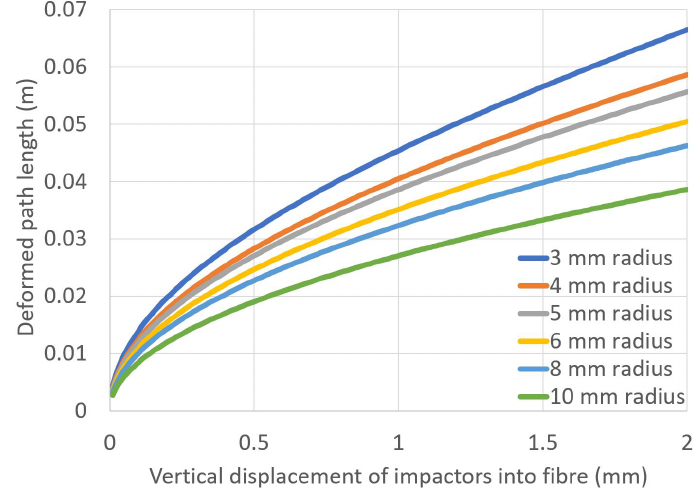
Figure 10. Calculation of the deformed fibre path length as the impactors are brought into contact with the